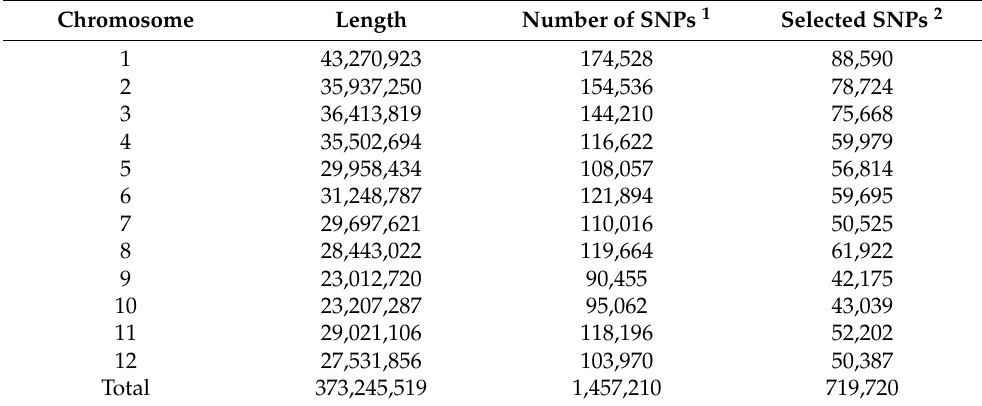
Table 2. Chromosome-wise distribution of single-nucleotide polymorphisms (SNPs) between two